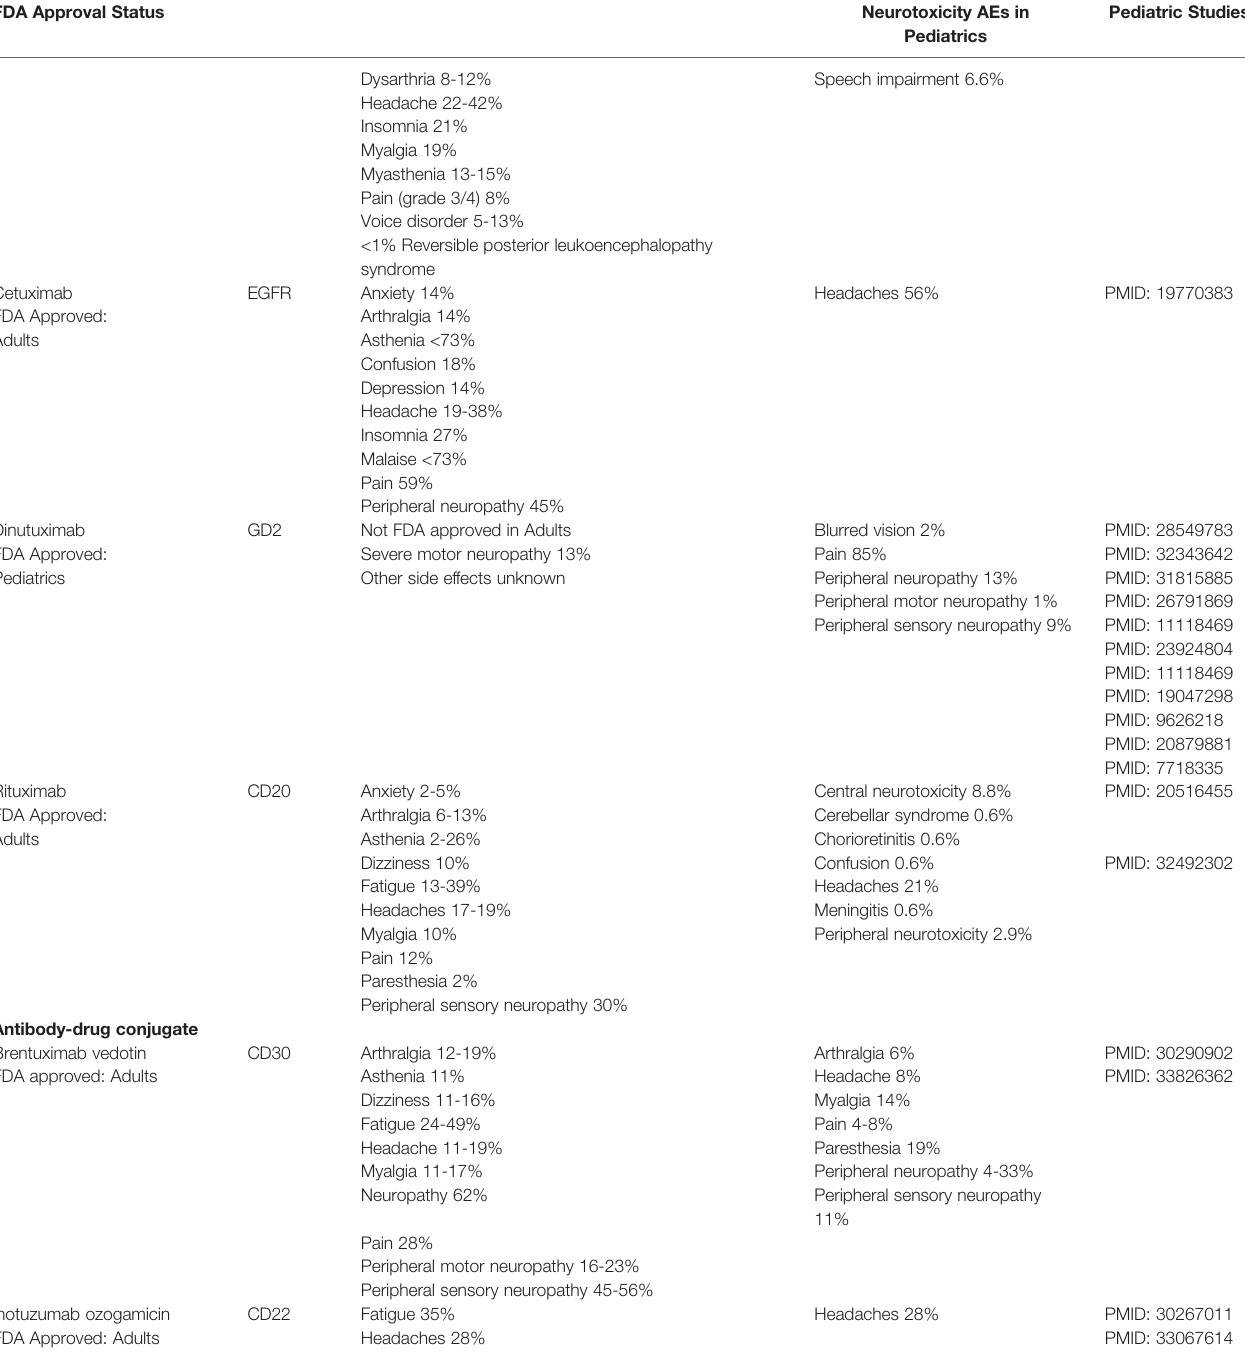
Drug Name FDA Approval